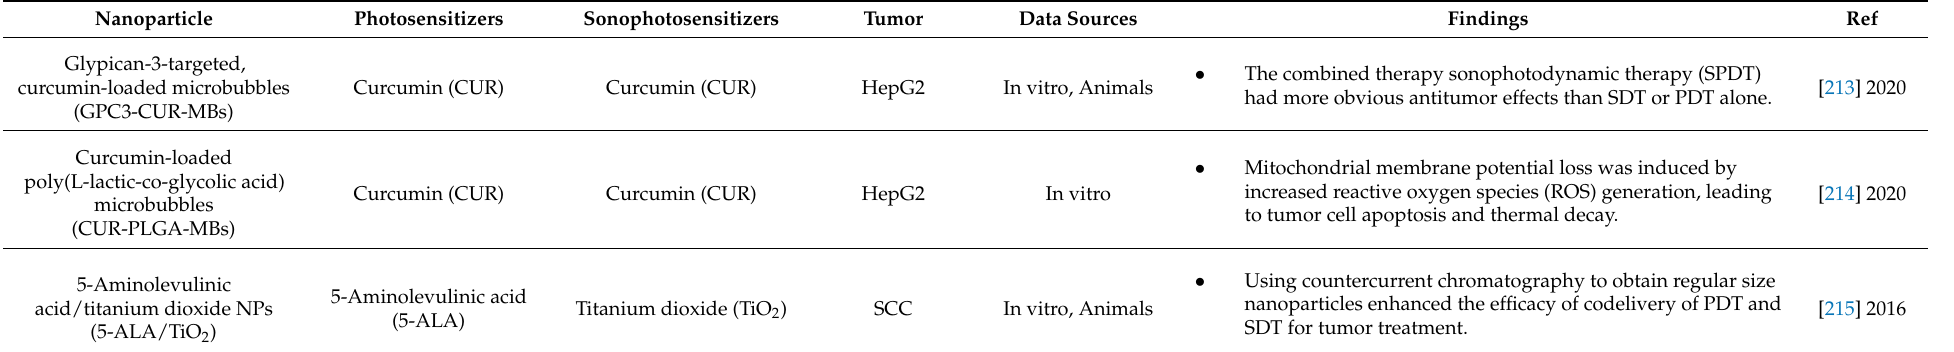
Table 7. Codelivery of photosensitizers and sonophotosensitizers based on